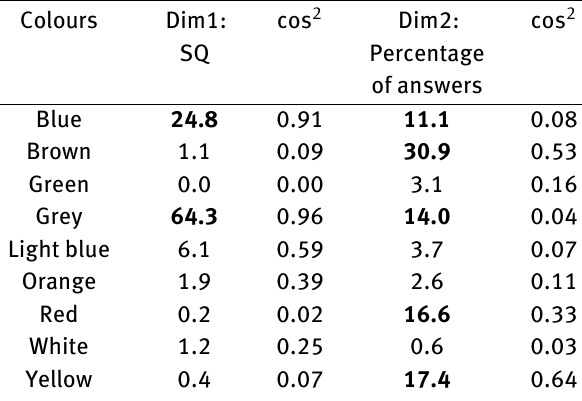
Table 5: Dimension contribution and quality of the columns repre- sentation (cos 2 ).